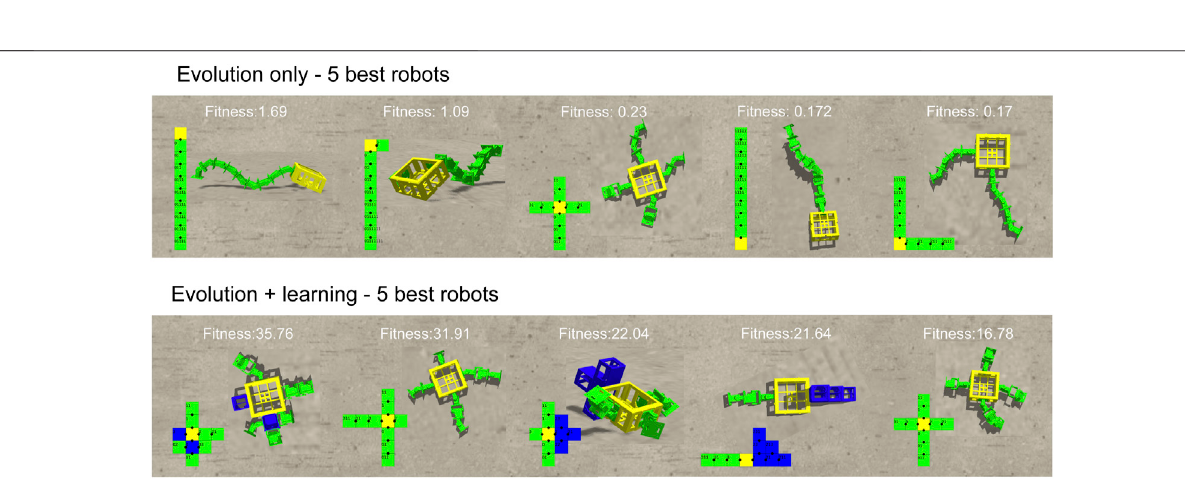
Frontiers in Robotics and AI |